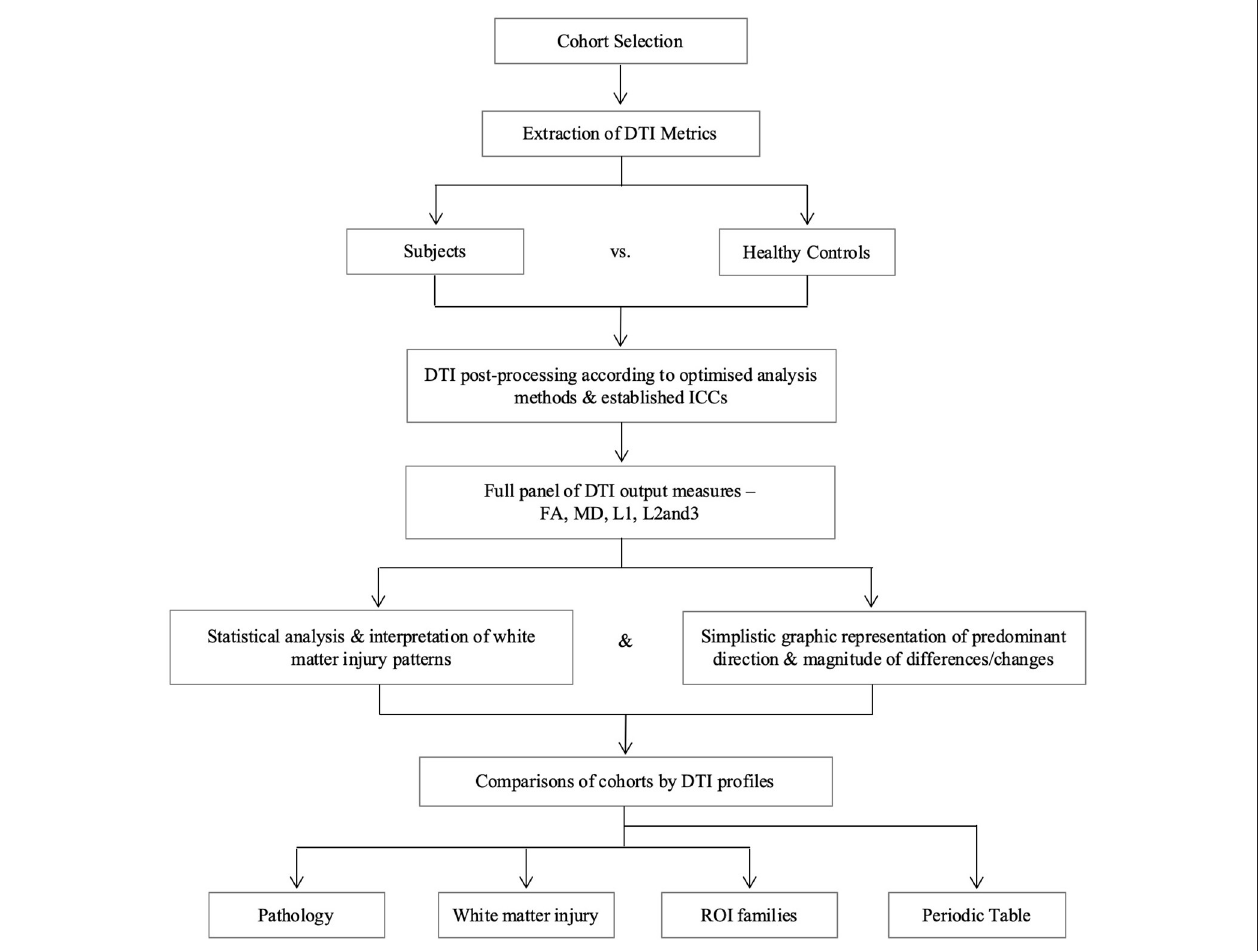
FIGURE 2 | Overview of study methodology. We refer to axial and radial diffusivities by their eigenvalues for clarity (L1 and L2 and 3, respectively), to distinguish these measures from terms we use for pathological cohorts. DTI, diffusion tensor imaging; FA, fractional anisotropy; ICC, intraclass correlation coefficient; L1, axial diffusivity, L2 and 3, radial diffusivity; MD, mean diffusivity; ROI, region of